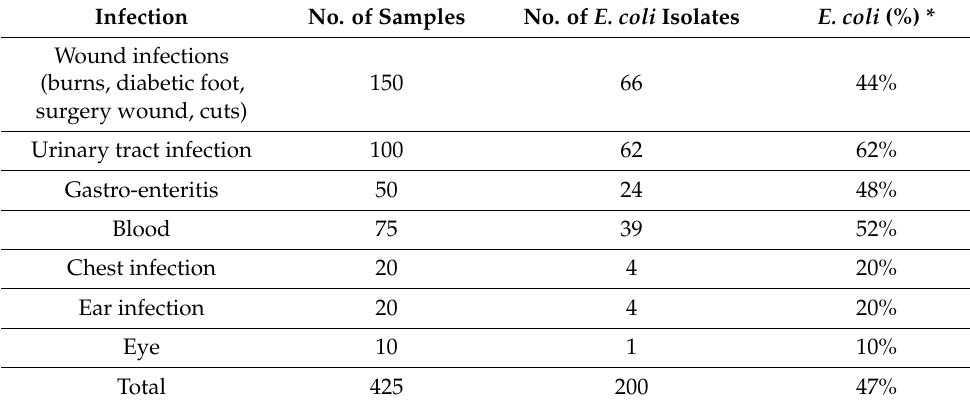
Table 1. Prevalence of E. coli among different clinical